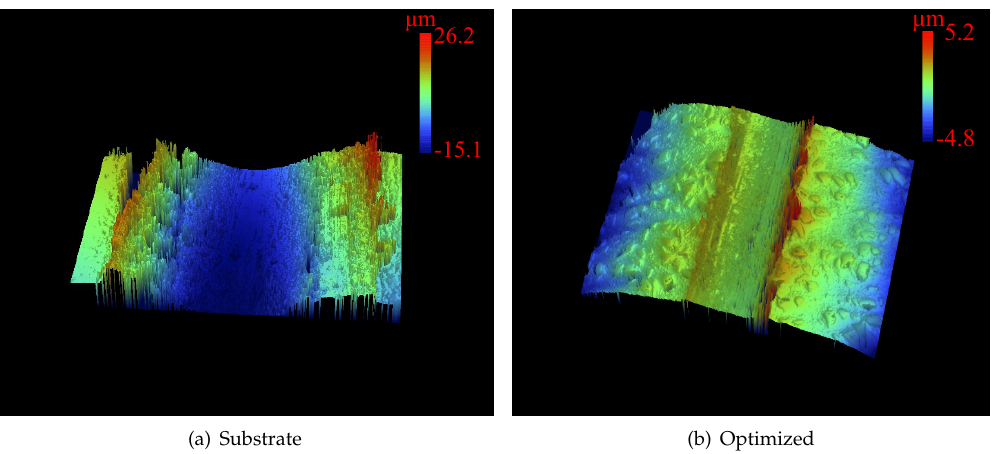
Figure 16. Comparison of 3D worn morphologies of substrate and optimized clad